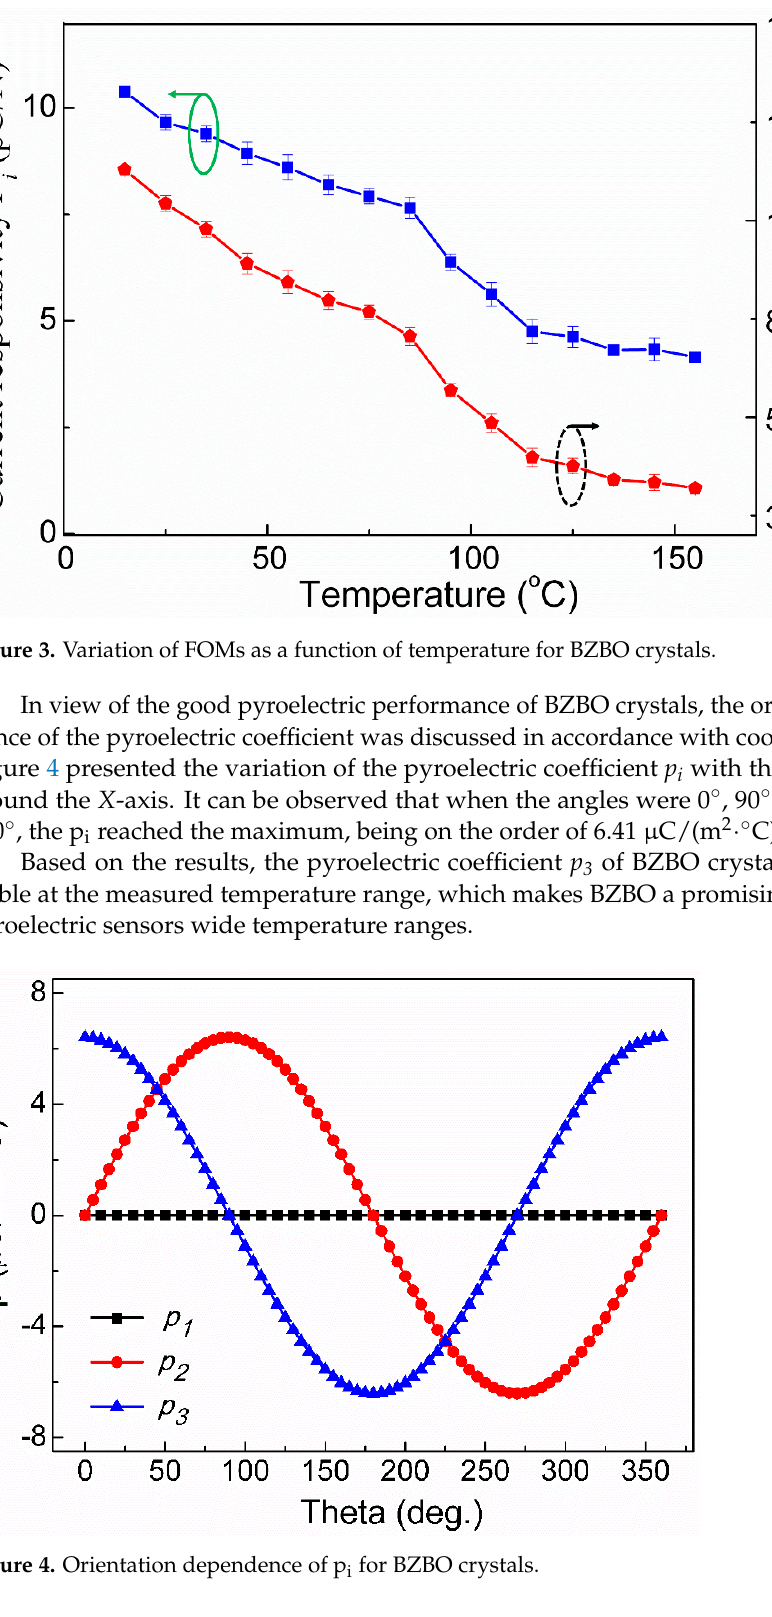
Figure 3. The F i and F d were decreased when the temperature increased, where the F i was 10.38 pm/V at 15 °C and 4.14 pm/V at 155 °C. The detectivety F d was 11.31 × 10 − 5 /Pa 1/2 at 15 °C and decreased to 3.20 × 10 − 5 /Pa 1/2 when the temperature was at 155 °C.